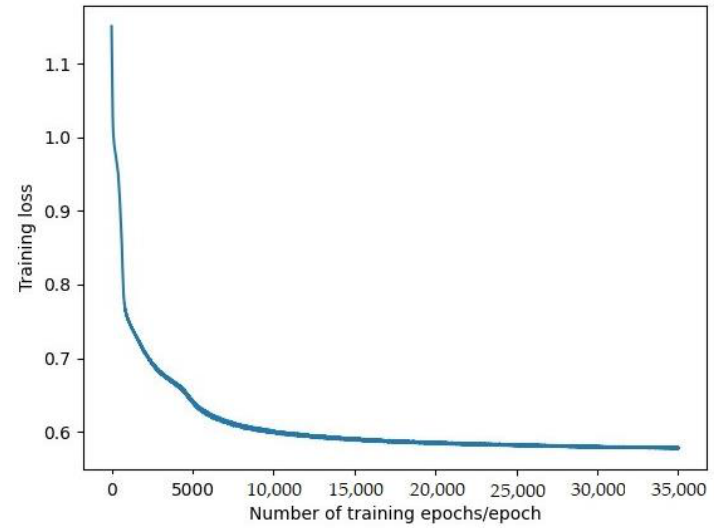
Figure 9. Loss during training.